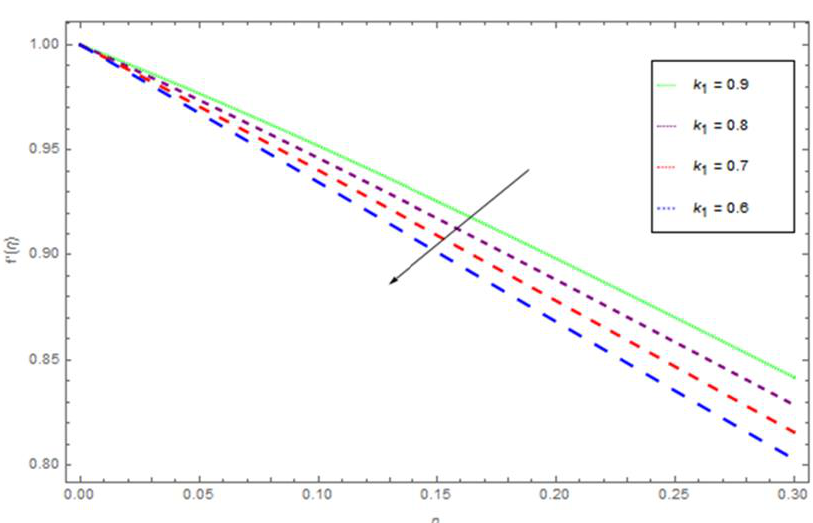
Figure 3. The variation of f